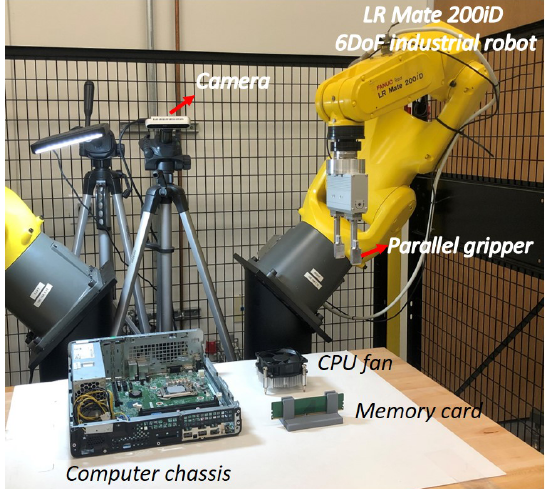
Figure 14. Experimental setup.